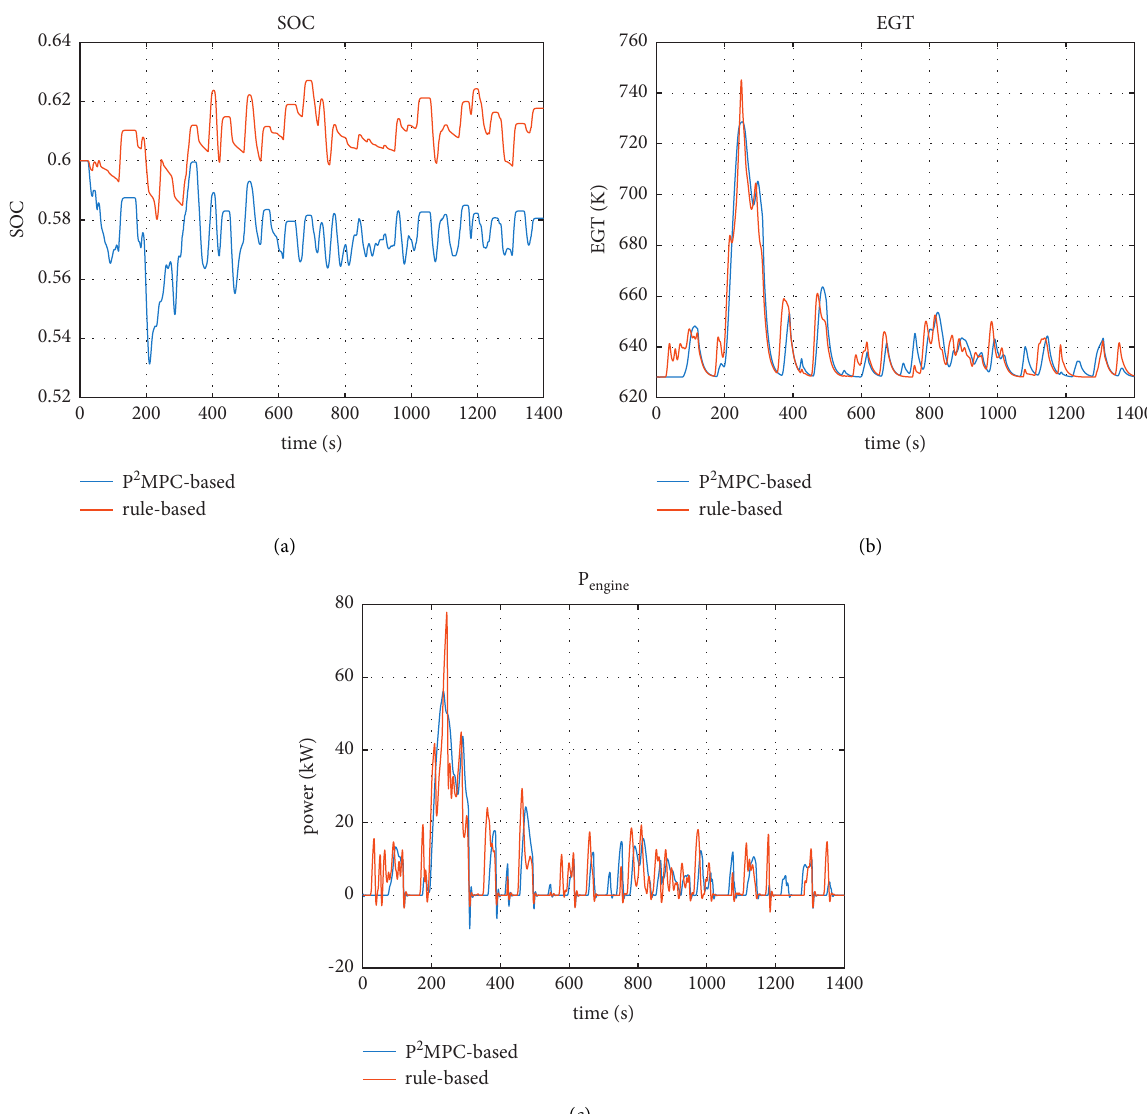
Figure 21: Simulation results comparison based on UDDS. (a) SOC of power battery. (b) EGT of turboshaft engine. (c) Output power of turboshaft